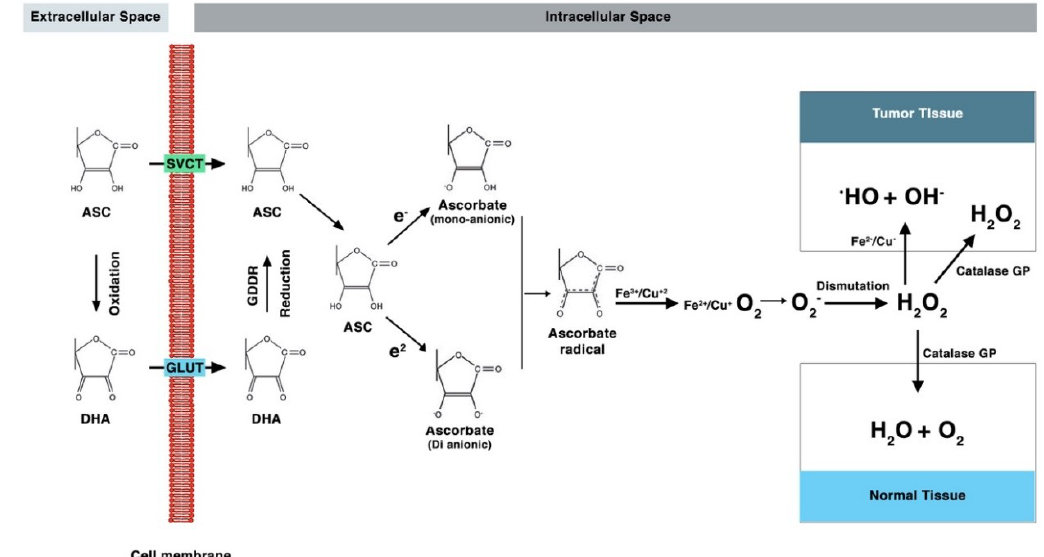
Figure 3. Mechanism of action of Vitamin C, and its oxidized forms’ cellular uptake via different transporters (ASC: ascorbic acid; DHA: dehydroascorbic acid; SVCT: sodium–ASC co-transporters; GLUT: glucose transporters; GDDR: glutathione-dependent dehydro-ascorbate reductase).